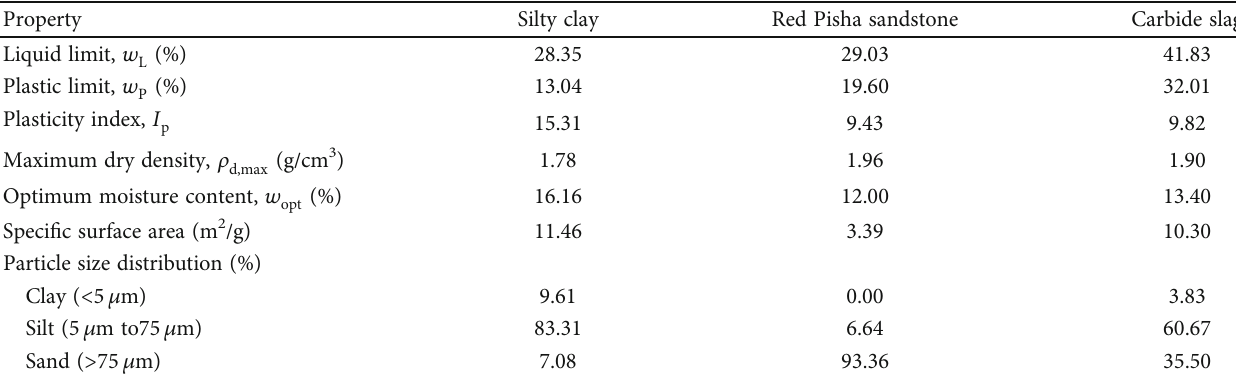
Table 1: Basic physical parameters of raw test materials [19].